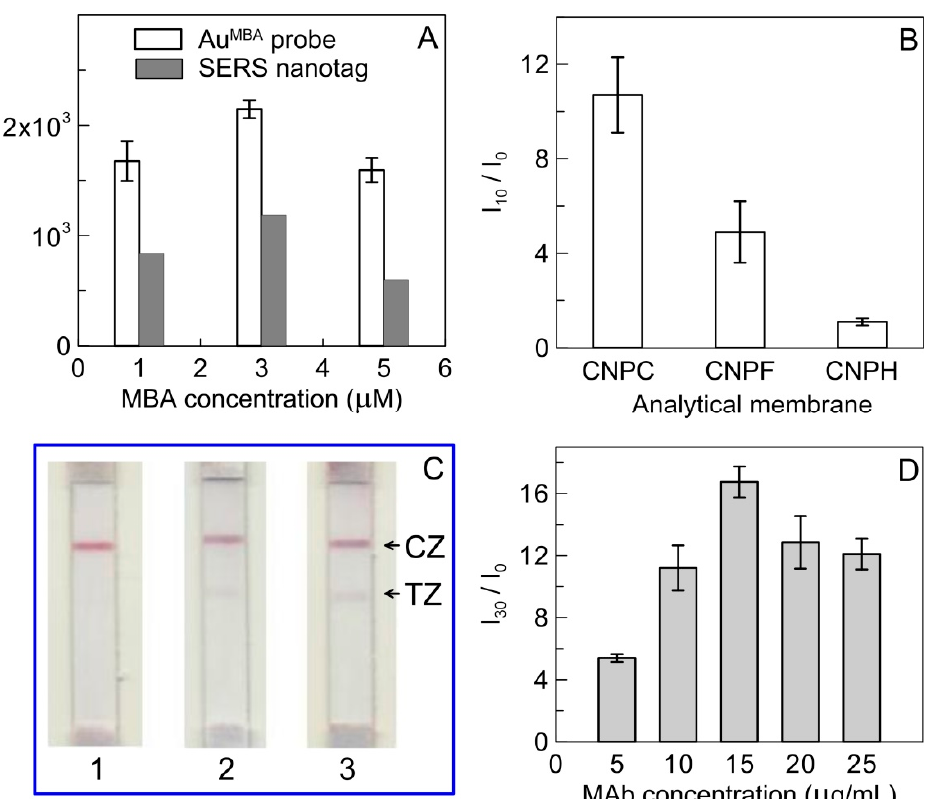
Figure 3. ( A ) Dependence of the Raman intensity on the concentration of MBA in the Au MBA probe and SERS nanotag. ( B ) Optimization of analytical membrane. ( C ) Images of test strips after conventional procedure of LFIA using SERS nanotags with 1 µM (1), 3 µM (2), and 5 µM (3) of MBA. ( D ) Optimization of antibody concentration to prepare SERS nanotags; the positive control contains 10 or 30 ng/mL of RBD. PBS containing 1% v/v Tween 20 is used as a negative